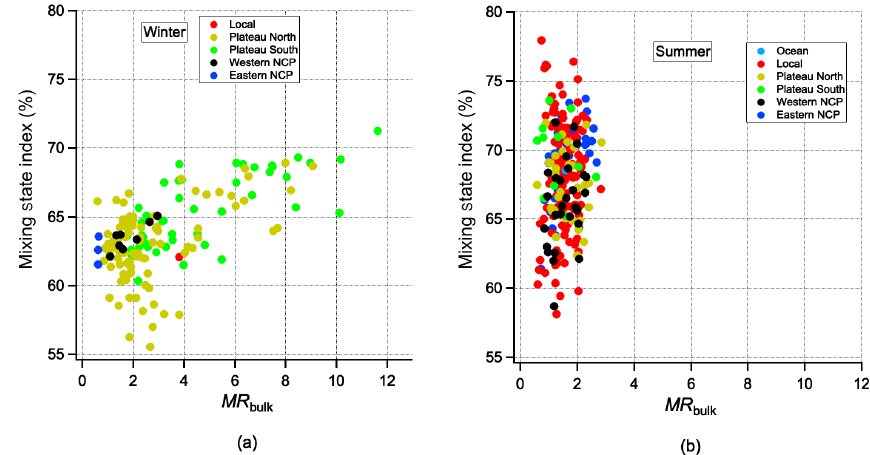
Figure 11. Air mass sources contribute to the MR and mixing state index for summer (a) and winter (b) .